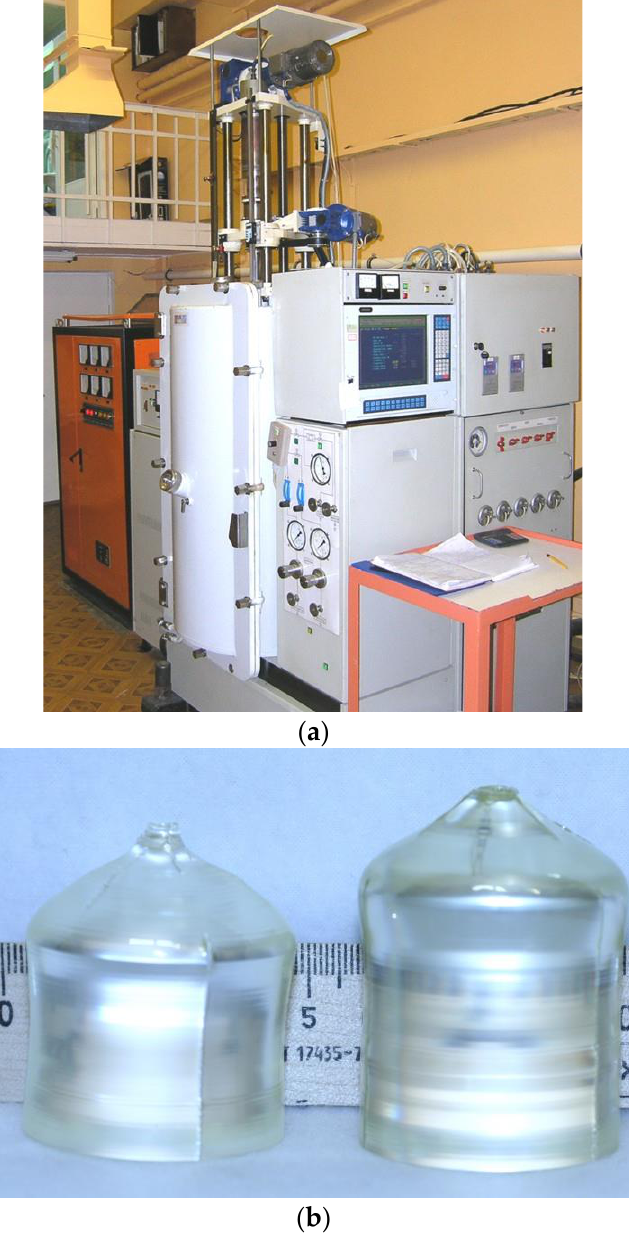
Figure 2 . Granat facility for growing LN crystals by the Czochralski method ( a ); NSLN1 and NSLN2 crystals after disassembling the thermal unit ( b ). Figure 2a is reprinted with permission from Ref. [17], 2022, Elsevier.